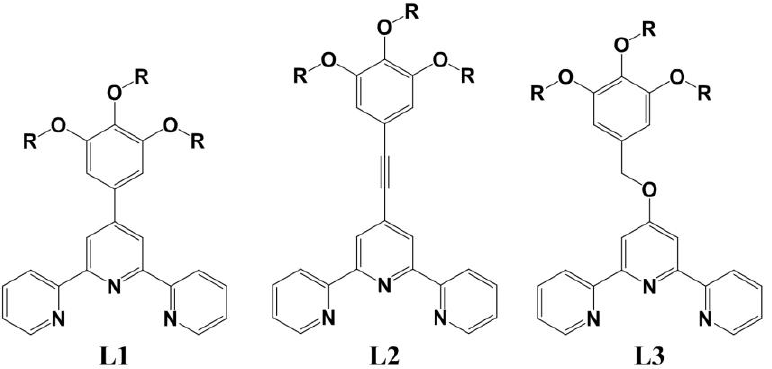
Figure 1. Ligands used to form the crystalline complexes described in the present work, for which R = CH 3